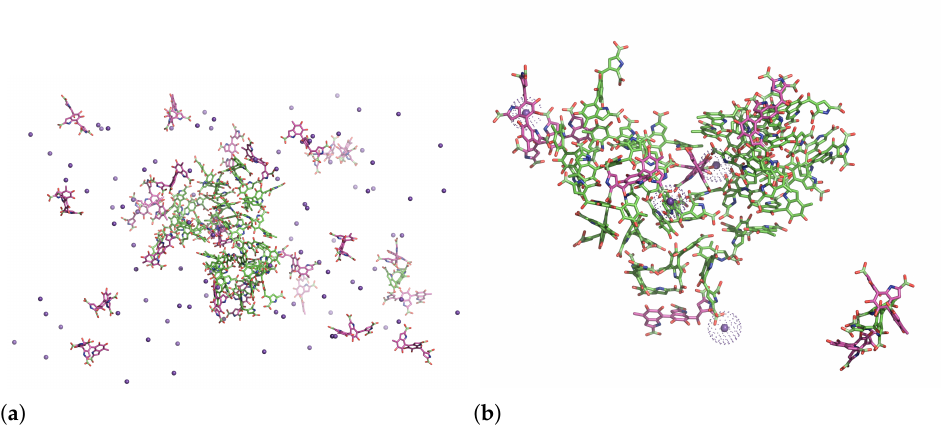
Figure 7. Mixture of 25 uncharged (green) and 25 charged (pink) DHICA eumelanins. K + ions (purple spheres) were added to the system to neutralize it. ( a ) Snapshot of the system at 1971ns and ( b ) a zoomed-in view showing charged DHICA eumelanins within 3Å of uncharged ones. Water molecules are not shown for better